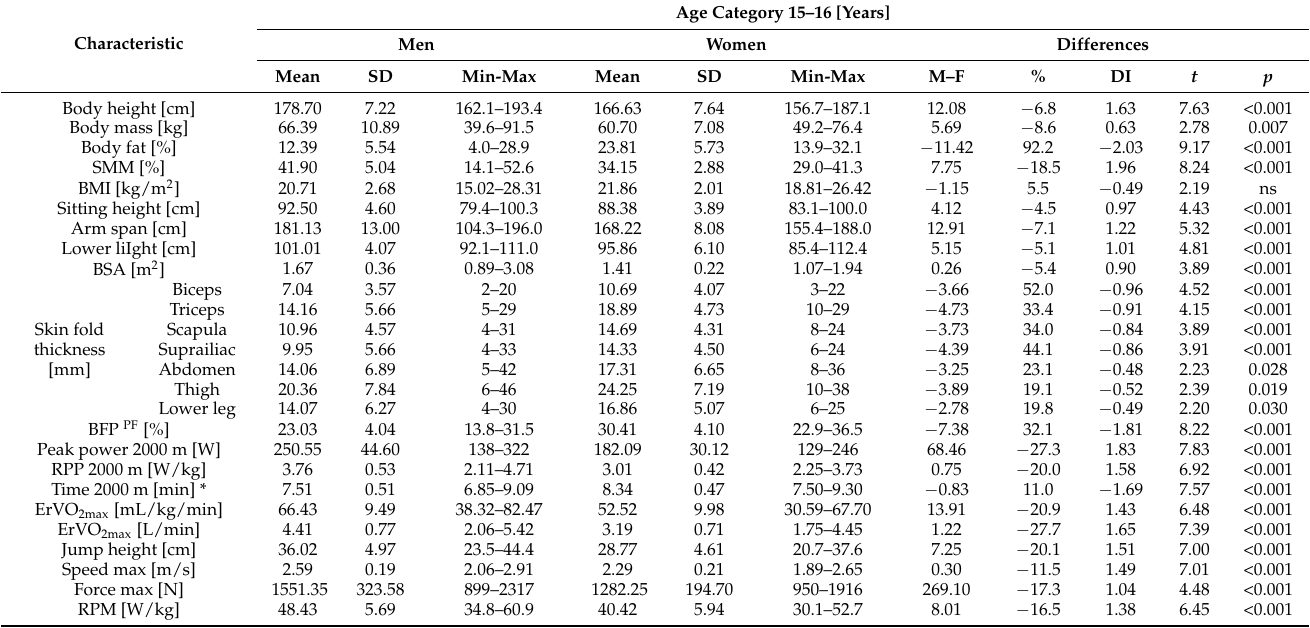
Table 1. Sexual dimorphism of anthropometric, physiological, and motor characteristics in rowers aged 15–16 years and statistical significance of